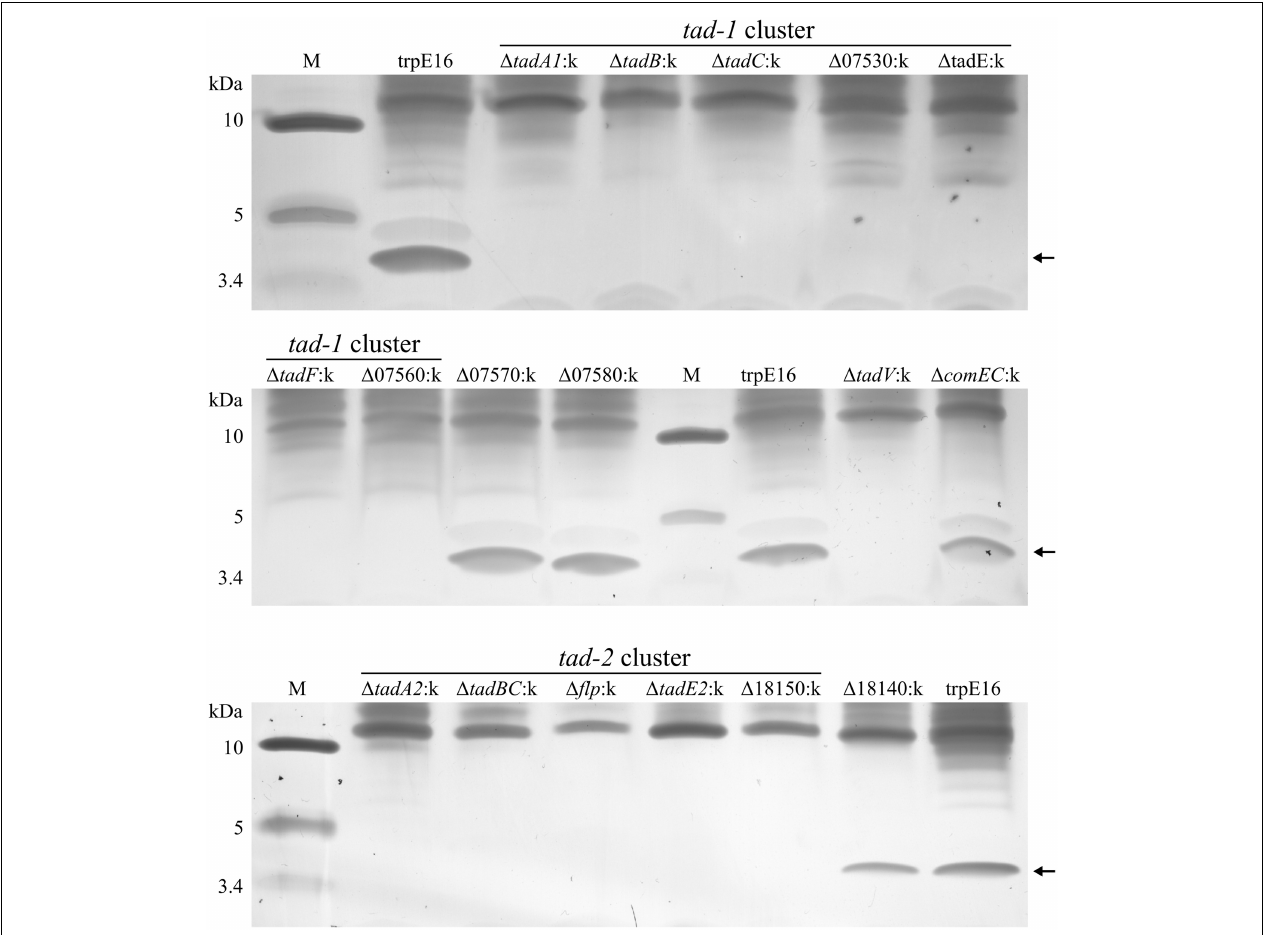
FIGURE 4 | Tris-tricine SDS-PAGE analysis (silver staining) of extracellular sheared fractions from M. luteus trpE16 and selected non-polar tad gene disruption mutants. All the strains were grown under competence-inducing conditions and the preparation of enriched